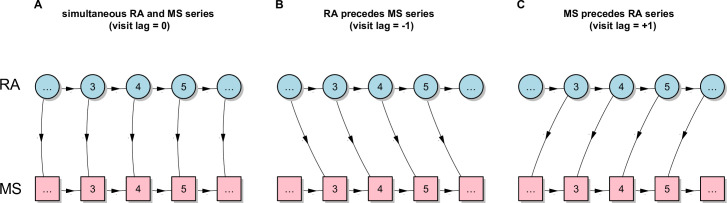
A graphical illustration of the three possible scenarios derived by CCF.Panel A shows the two series of data that evolve simultaneously, panel B shows a series of RA data that precedes the MS series by 1 visit, and panel C shows a series of MS data that precedes the RA series by 1 visit.